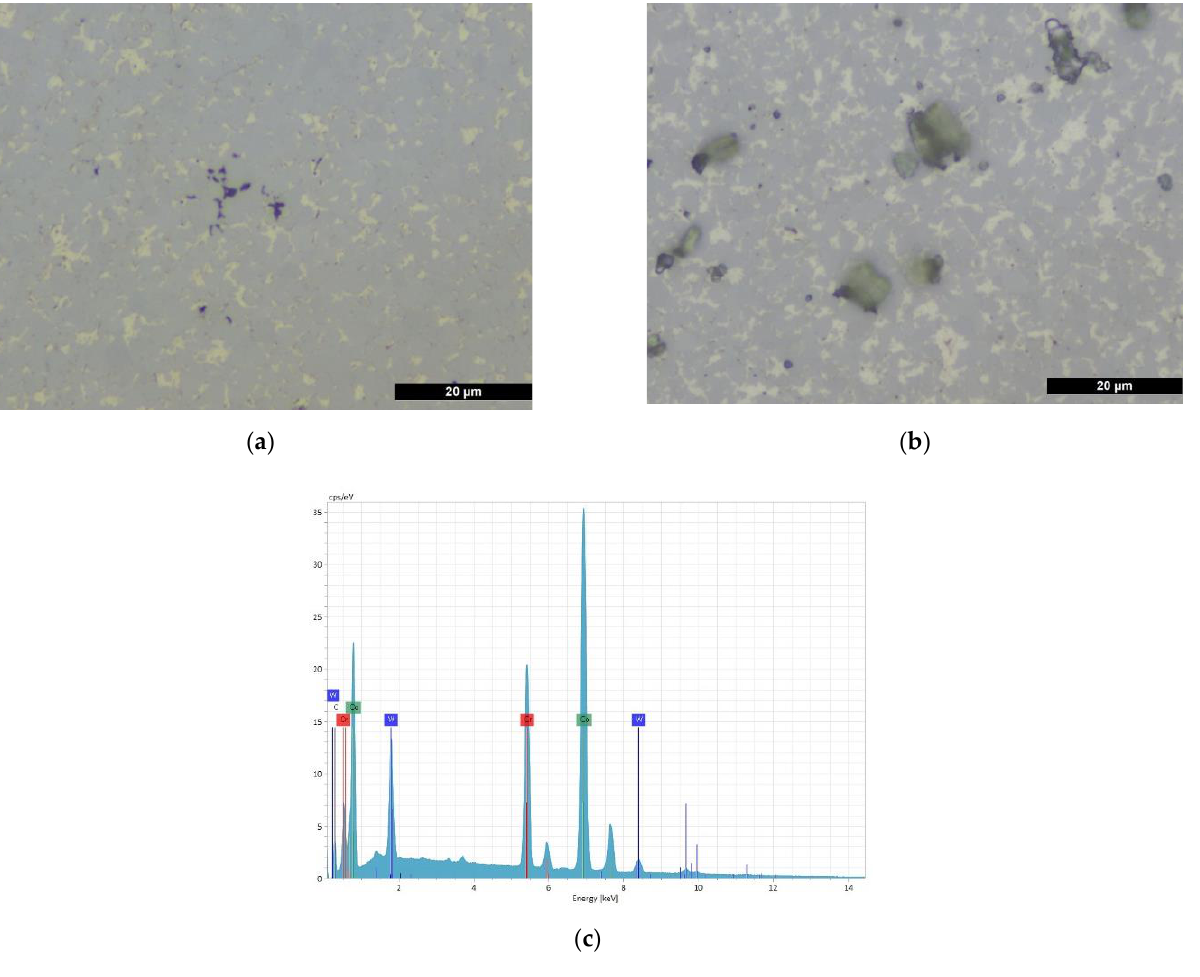
Figure 8. Ni-base grades: precipitation of free-C at [Cr] = 10 m% ( a ), Cr-carbides at [Cr] > 10 m% ( b ) and related EDS spectrum ( c ). For details on the samples, see Table 2.